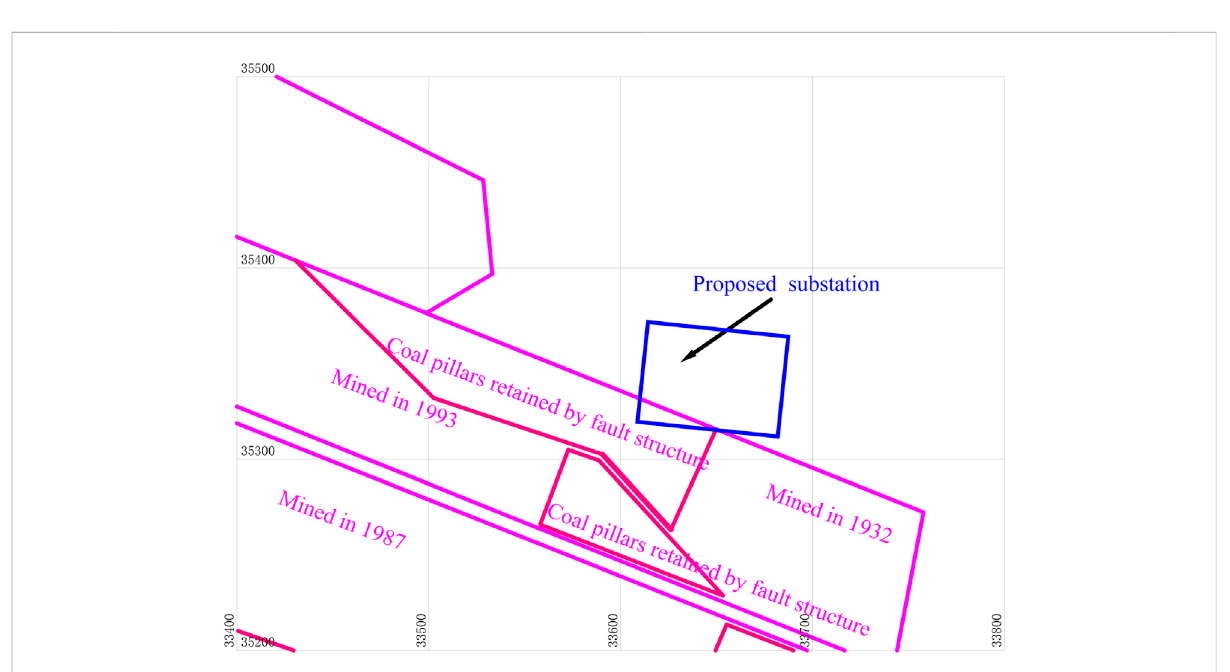
FIGURE 1 The distribution of coal mining projects underlying and near the